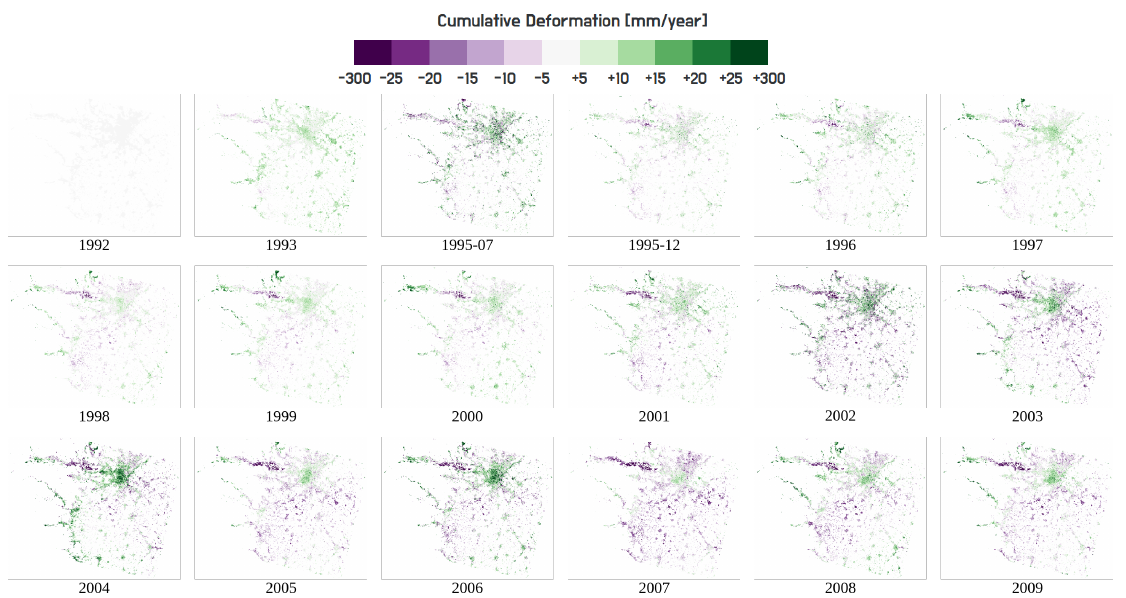
Figure 8. Visualization of the raster deformation time series of Turin on GeoServer.